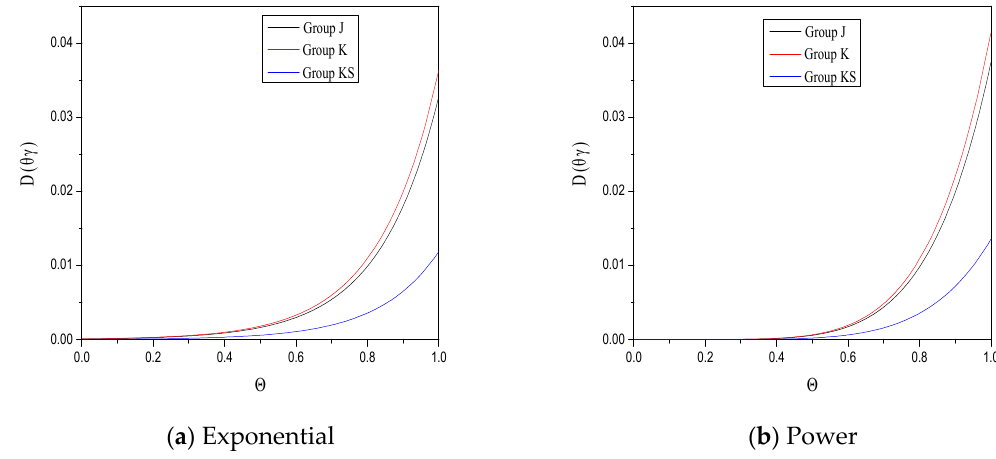
Figure 9. Relationship between 𝐷(𝜃𝛾) and saturation.